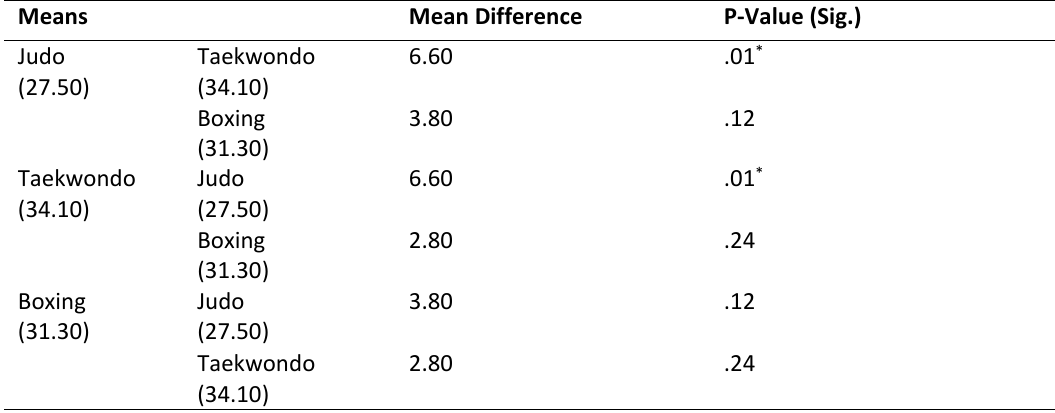
Table 3. Analysis of least significant difference (LSD) post-hoc test among judo, taekwondo and boxing players on the sub-parameter clothing and appearance